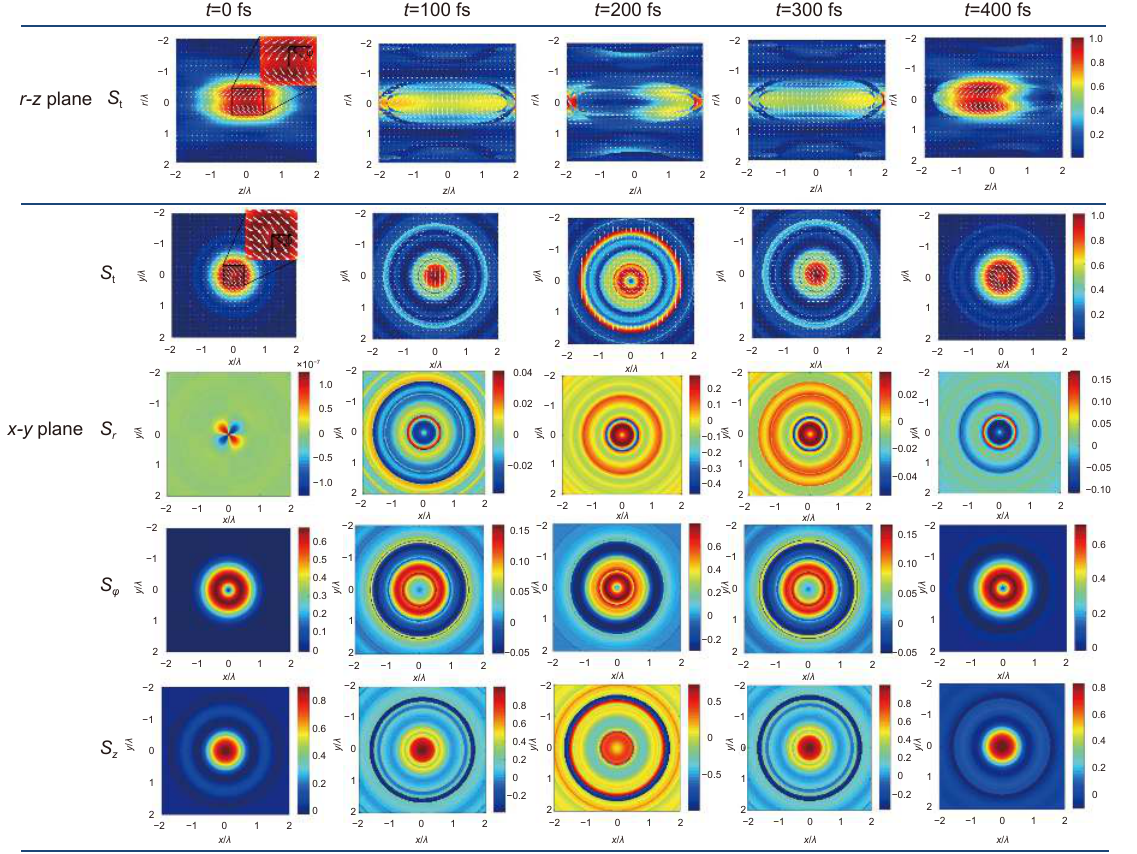
Fig. 5 | Normalized Poynting vector fields along the propagating direction (the first row) and on the focal plane (the second to last rows) of the tightly focused radially polarized light with the first-order vortex at different temporal intervals when t = 0 fs, 100 fs, 200 fs, 300 fs, and 400 fs, respectively. The total Poynting vector fields S t (the first row and the second row); radial Poynting vector fields S r (the third row) and azimuthal Poynting vector fields S φ (the fourth row) as well as longitudinal Poynting vector fields S z (the last row). Parameters are the same as those in Fig.